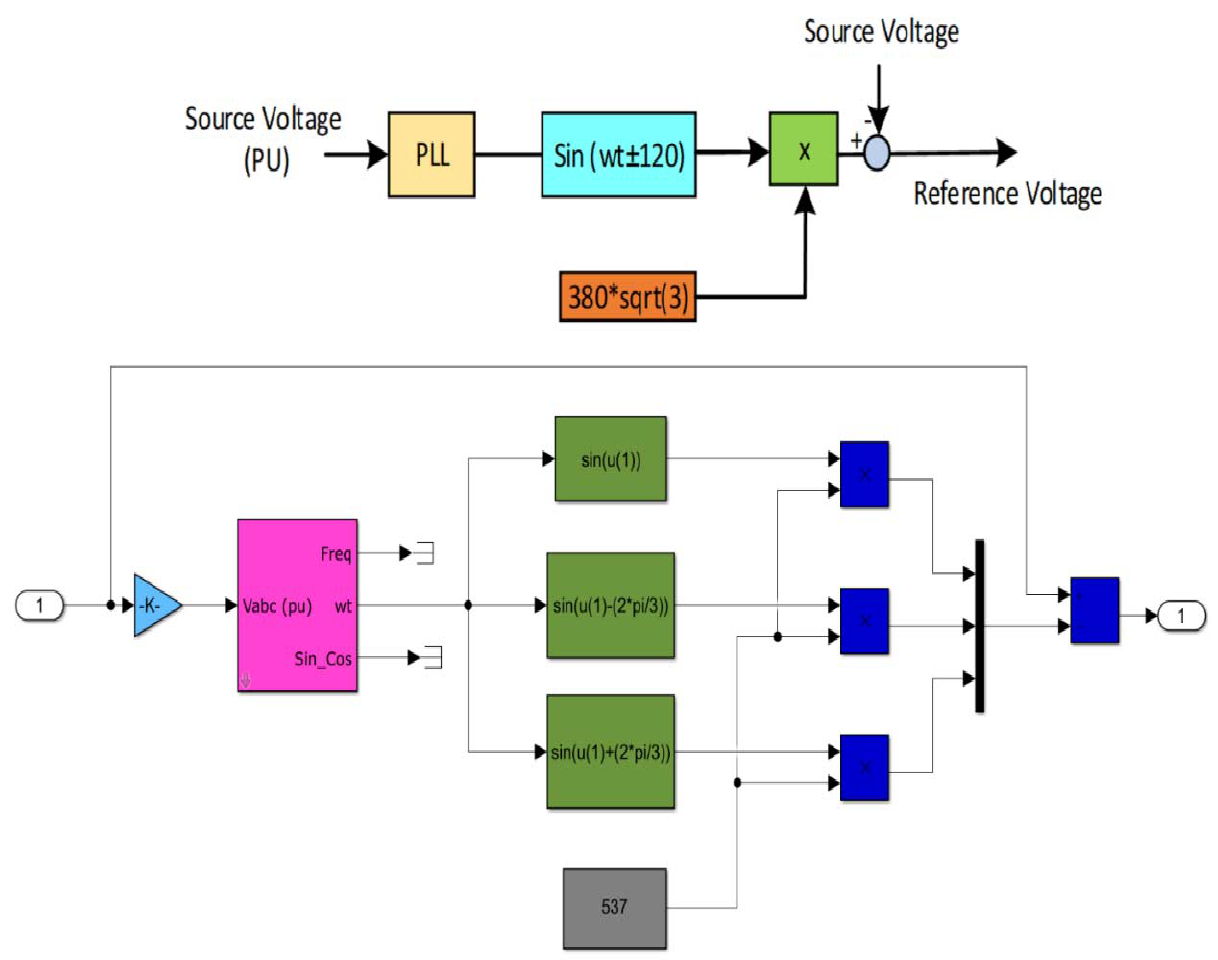
Figure 4. Series inverter controller simulation. Phase ‐ locked ‐ loop (PLL) is used for grid voltage monitoring, and its performance directly affects the dynamic response for the UPQC because it is a very effective way to detect abnormal operating conditions in the utility grid. The PLL regulator is scaled ac ‐